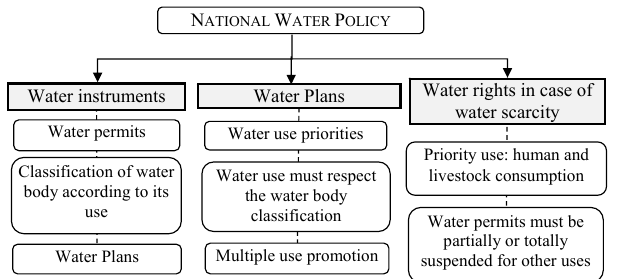
Figure 2. The relation between the National Water Policy and the principle “clearly defined